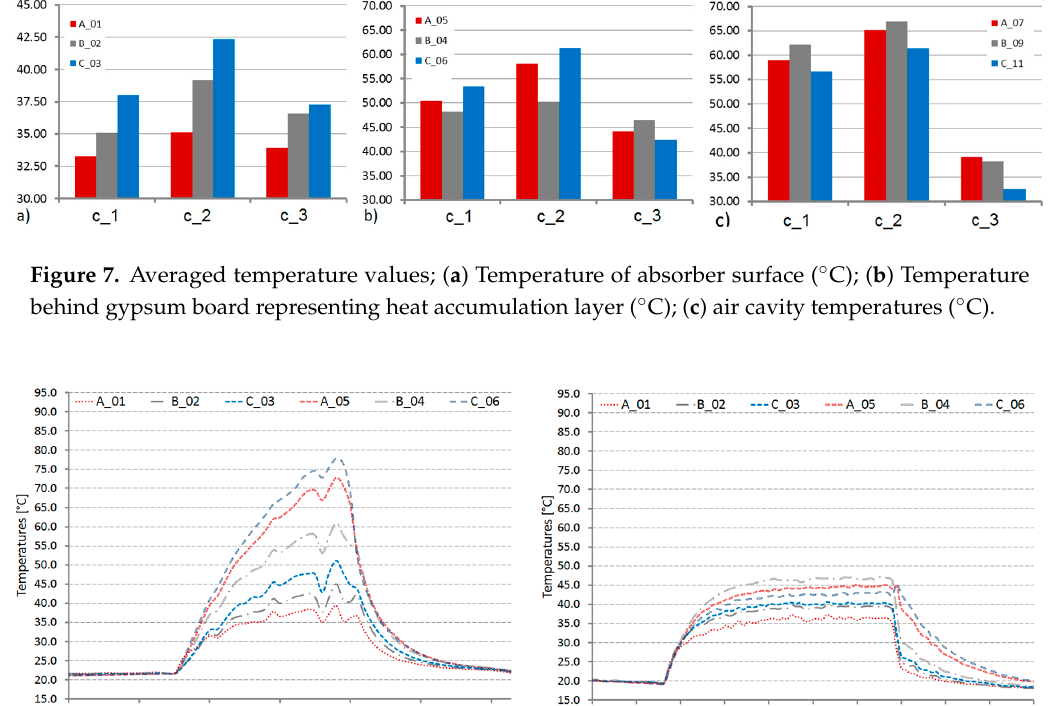
Figure 8. Temperatures behind gypsum board and absorber surface temperatures; ( a ) c_1 test case; ( b ) c_3 test case.